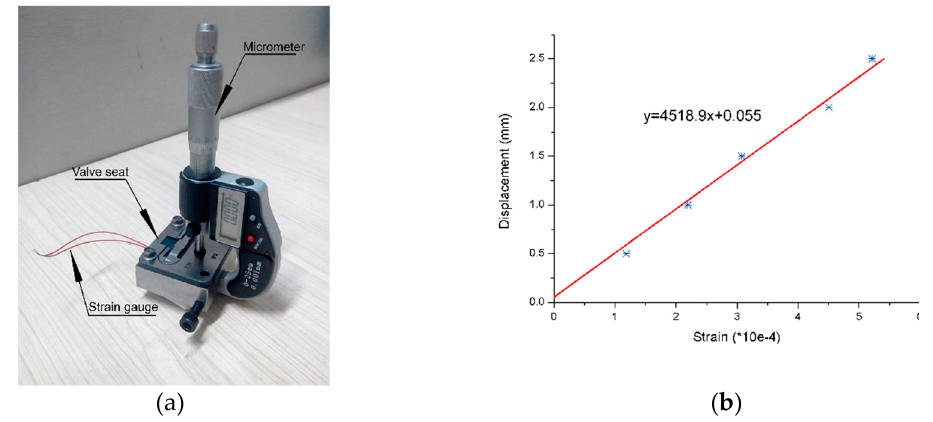
Figure 5. Calibration of the strain gauge: ( a ) The experimental facility; ( b ) The linear relation between the strain and the displacement of the reed valve.